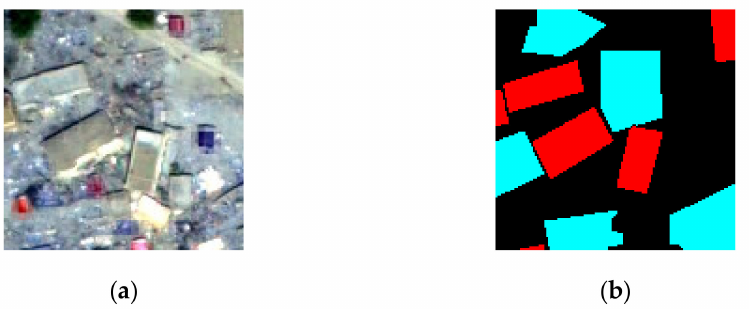
Figure 8. The original image and its ground truth map; red, blue and black represent the non- collapsed buildings, collapsed buildings and others. ( a ) Original image. ( b ) Ground truth